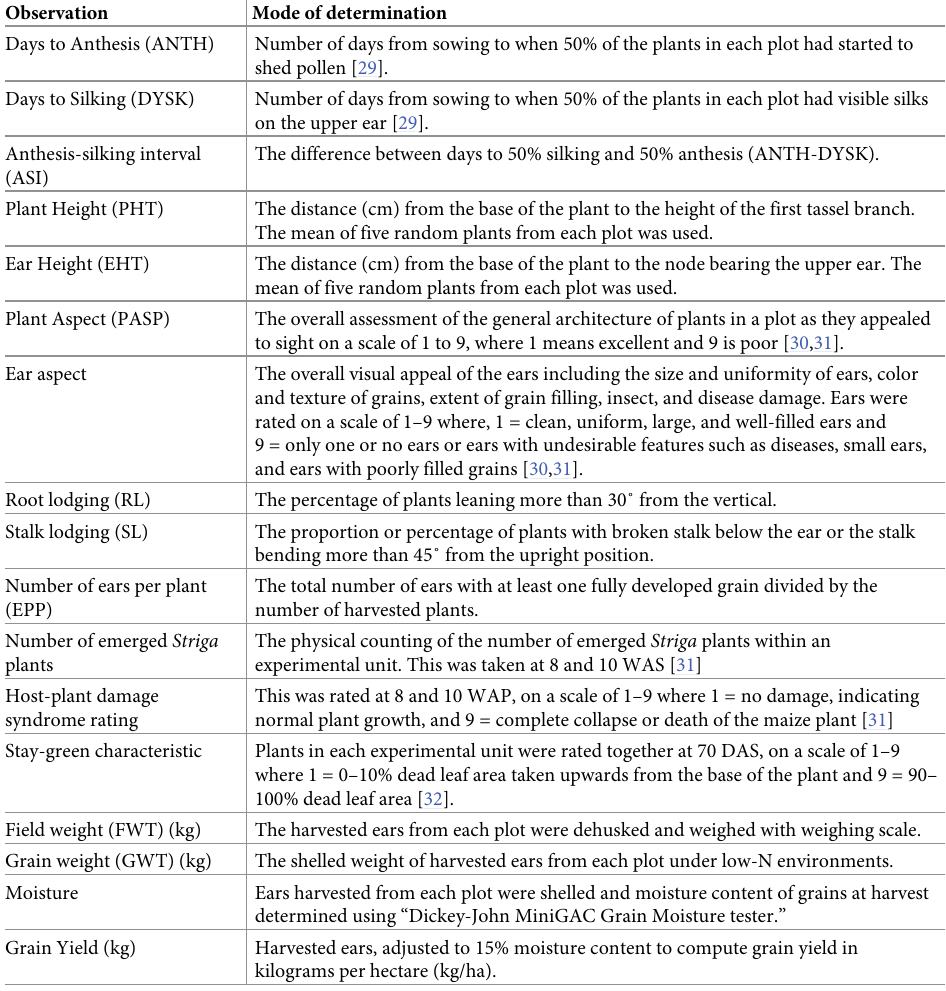
Table 2. Observations made on the agronomic traits and the mode of